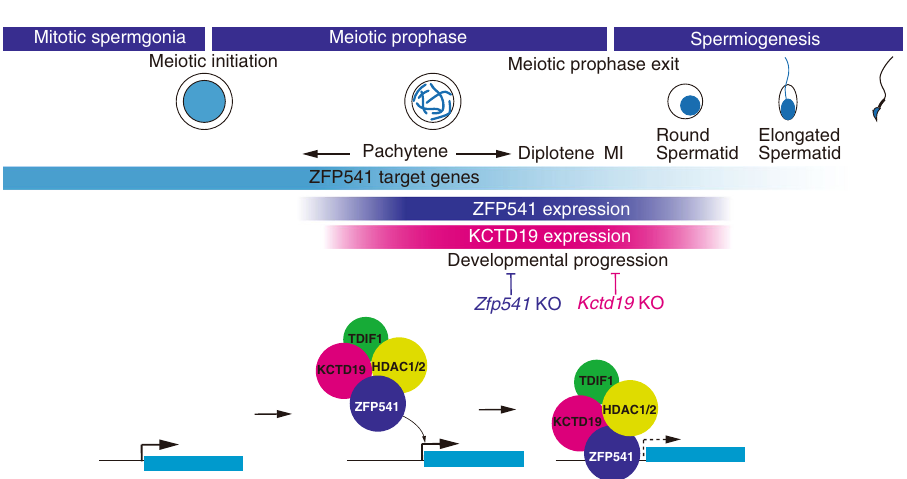
Fig. 9 The ZFP541 – KCTD19 complex is required for completion of the meiotic prophase. Schematic model of the ZFP541 – KCTD19 – HDAC1/2-TDIF1- containing complex that suppresses a subset of genes for the completion of the meiotic prophase. The timing of ZFP541 and KCTD19 protein expressions are shown along the developmental stages. ZFP541 and KCTD19 started to appear in the spermatocyte nuclei from early pachytene onward, and were still expressed in round spermatids. Vertical bars indicate the stages when the developmental progression is blocked in Zfp541 KO and Kctd19 KO